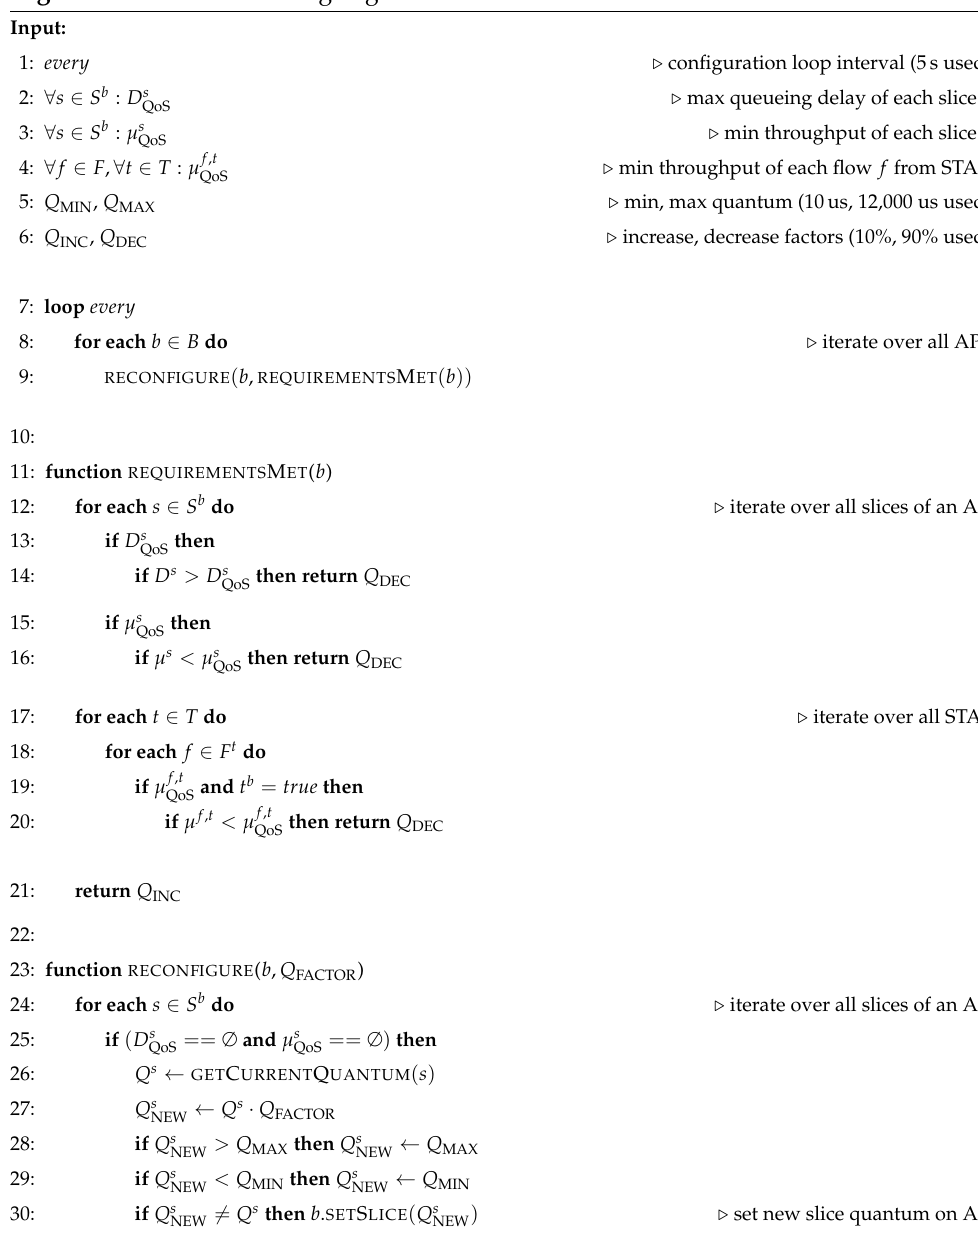
Algorithm 2 Network Slicing